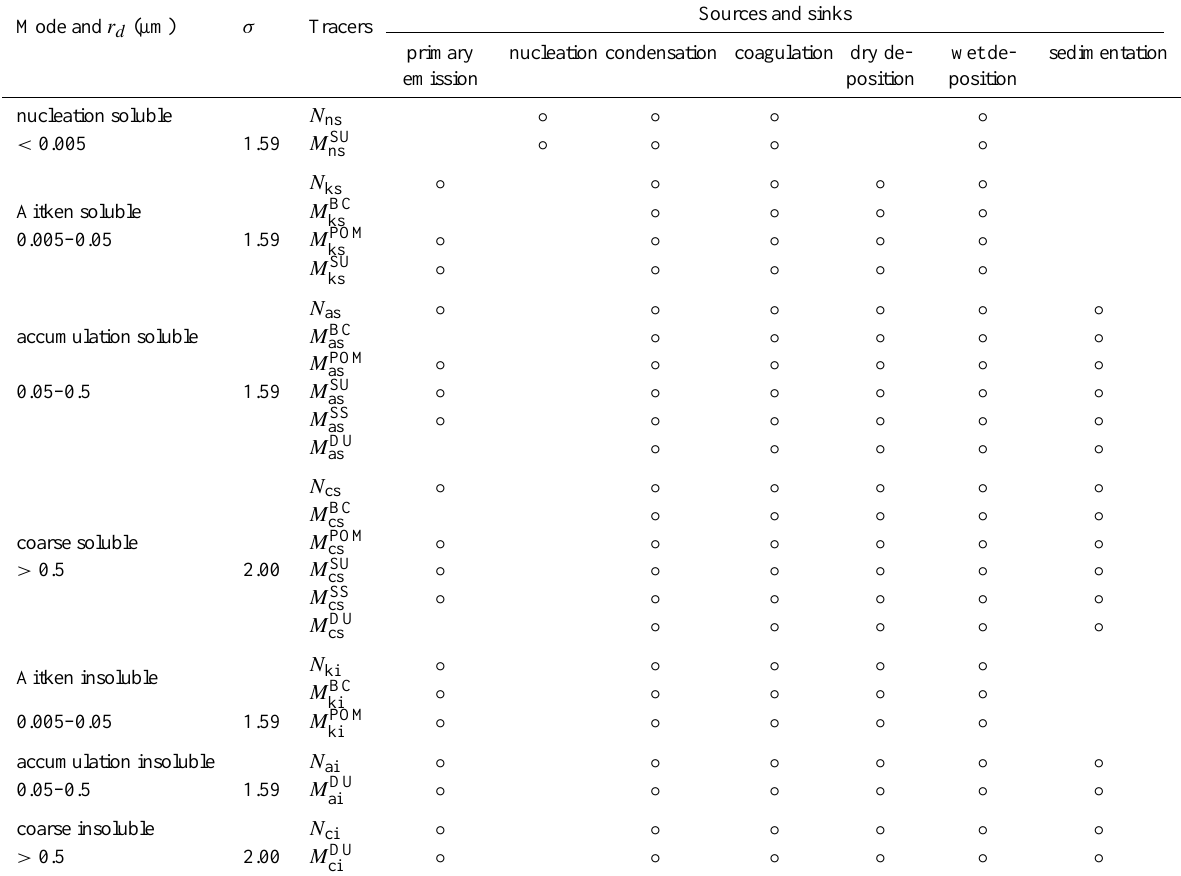
Table 3. The log-normal modes in the M7 module and the related sources and sinks of aerosol mass and particle number. r d stands for the dry radius of the aerosol particle; σ denotes the geometric standard deviation of the size distribution function. “ N ” and “ M ” in the third column stand for the number and mass concentrations, respectively. Their subscripts indicate the corresponding mode. The superscript of “ M ” indicate the composition. Small circles indicate that a certain tracer is affected by a specific process. Mode and r d